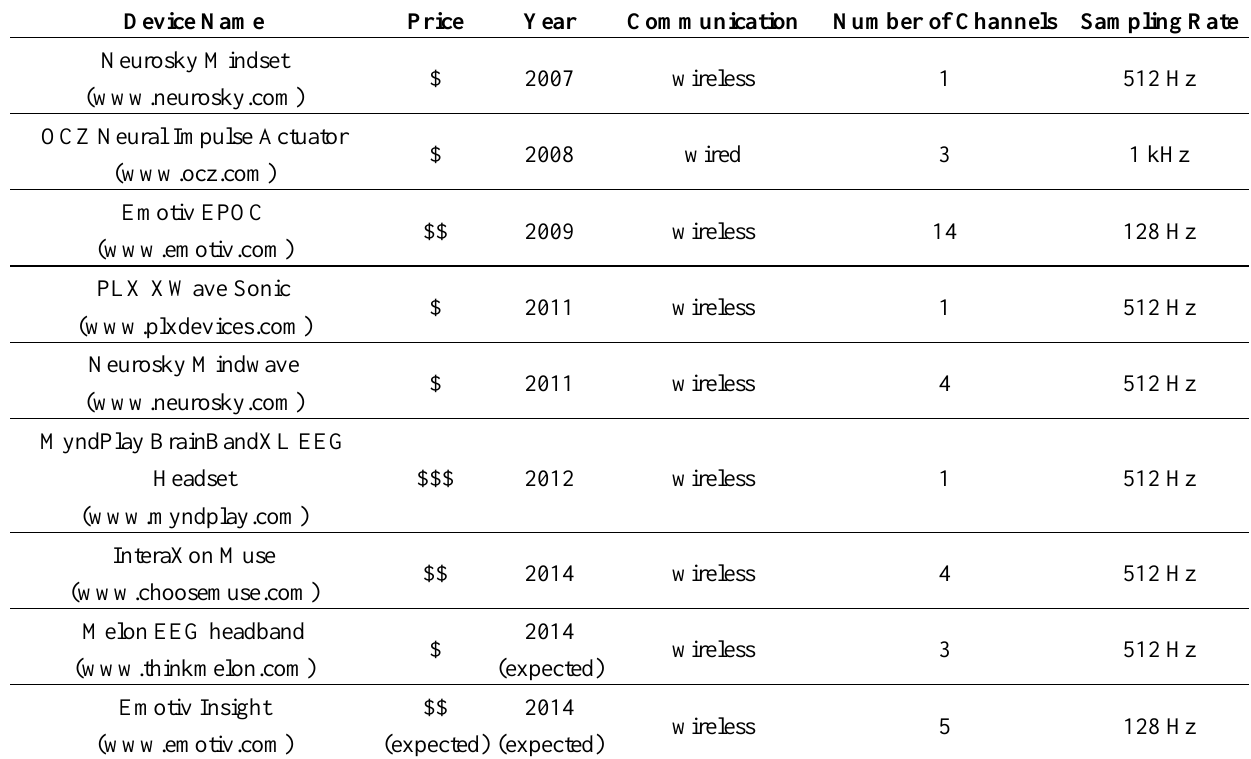
Table 1. EEG Devices and their specifications. $: <200, $$: 200~300, $$$: >300 (unit: US